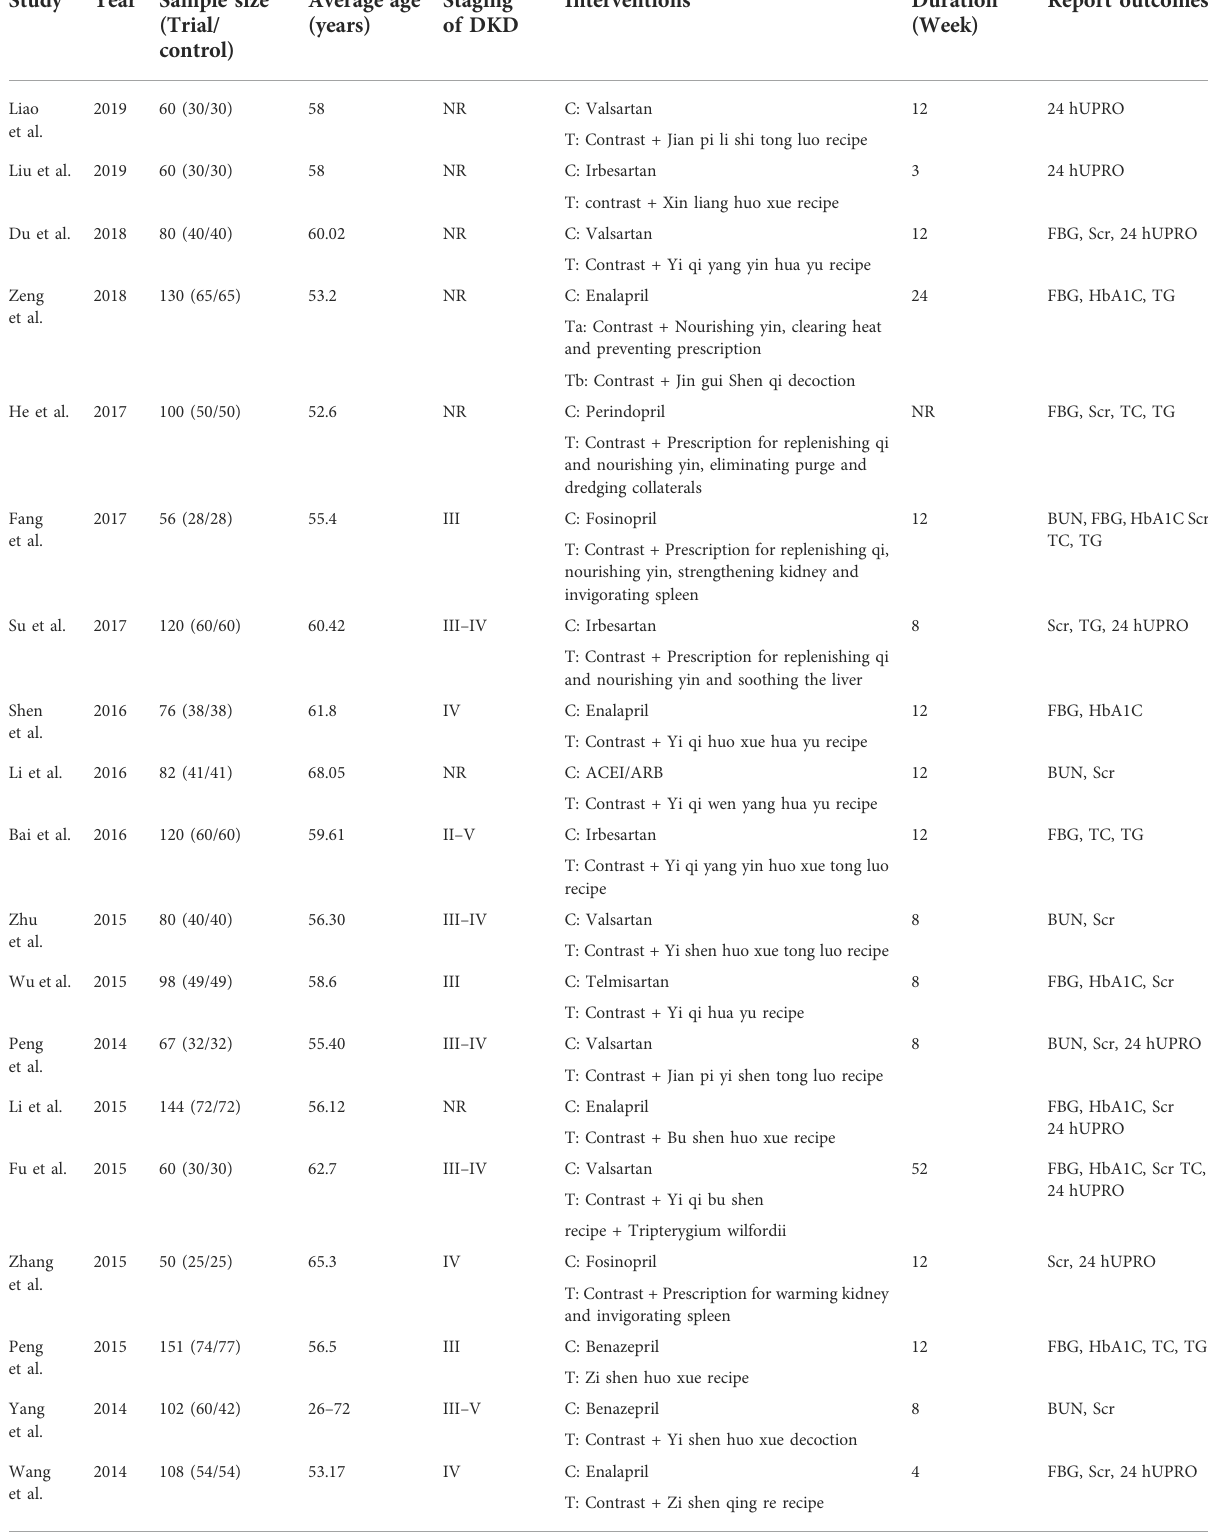
TABLE 1 Baseline characteristics of the included